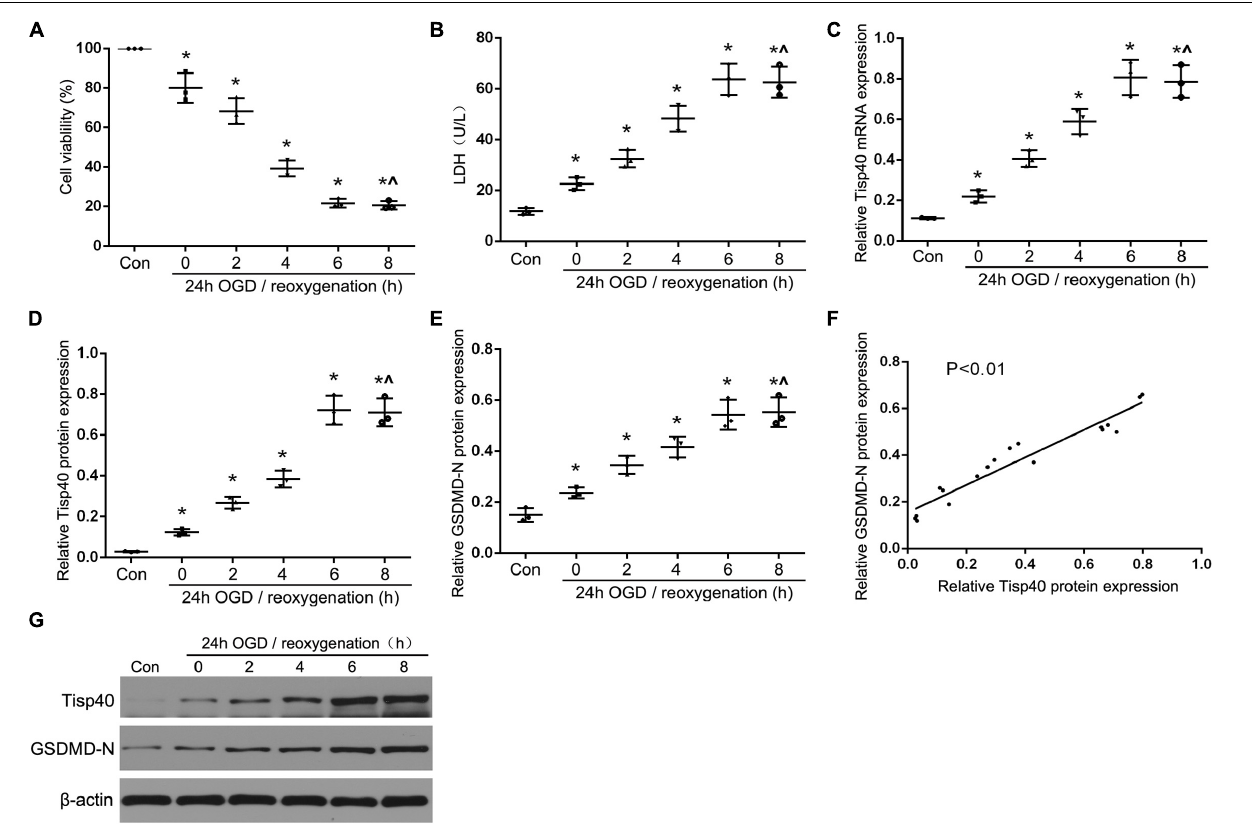
FIGURE 2 | Tisp40 and GSDMD-mediated pyroptosis were induced in OGD/R-stimulated TCMK-1 cell. (A) Cell viability was detected by CCK-8 assay. (B) The LDH release was detected by activity assays. (C,D,G) qRT-PCR and western blot analysis of Tisp40 expression at different durations of reoxygenation after 24 h OGD in TCMK-1 cells; (E,G) Western blot analysis of GSDMD-N protein expression at different durations of reoxygenation after 24 h OGD in TCMK-1 cells. (F) The correlation between the protein expression of Tisp40 and GSDMD-N was analyzed by Pearson’s correlation analysis in TCMK-1 cells. Data are expressed as the mean ± SD. n = 5 per group. * P < 0.05 vs. con, ∧ P > 0.05 vs. 24 h OGD and reoxygenation of 6 h, one-way